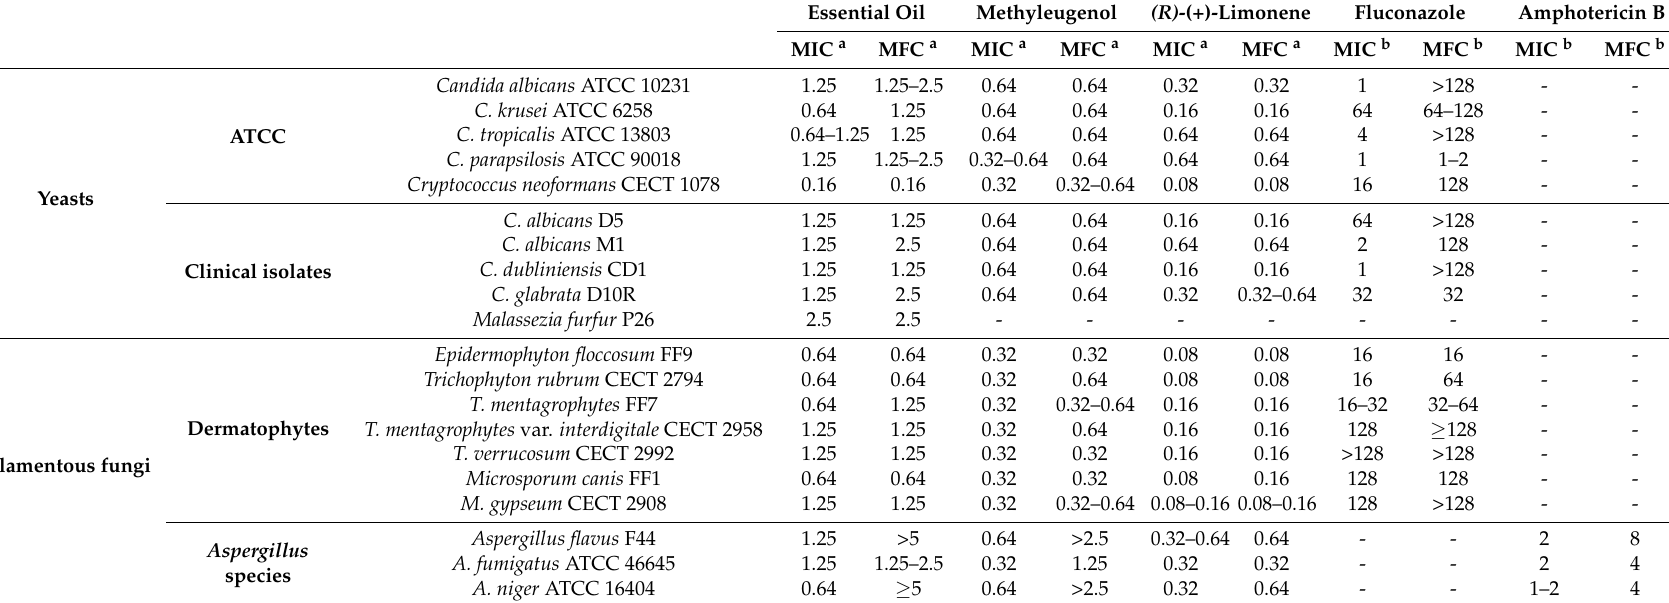
Table 2. Antifungal activity (MIC and MFC) of the Thapsia villosa (sample B) for yeast, dermatophyte, and Aspergillus